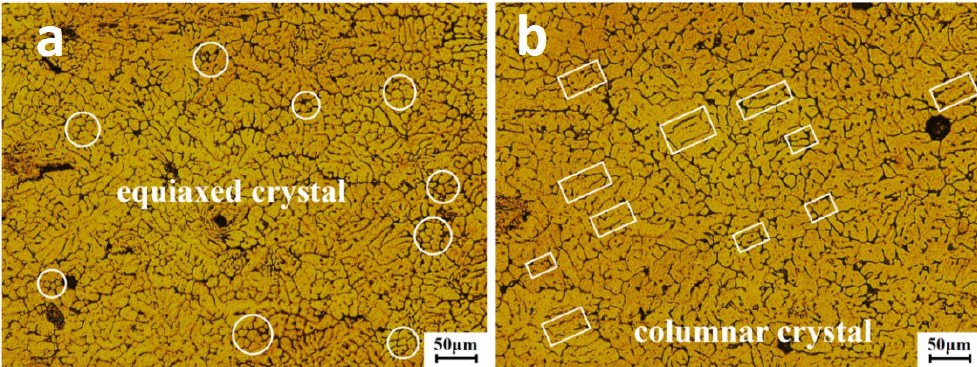
Figure 5. Microstructure of weld zone: ( a ) equiaxed crystals in weld zone; ( b ) columnar crystals in weld zone.